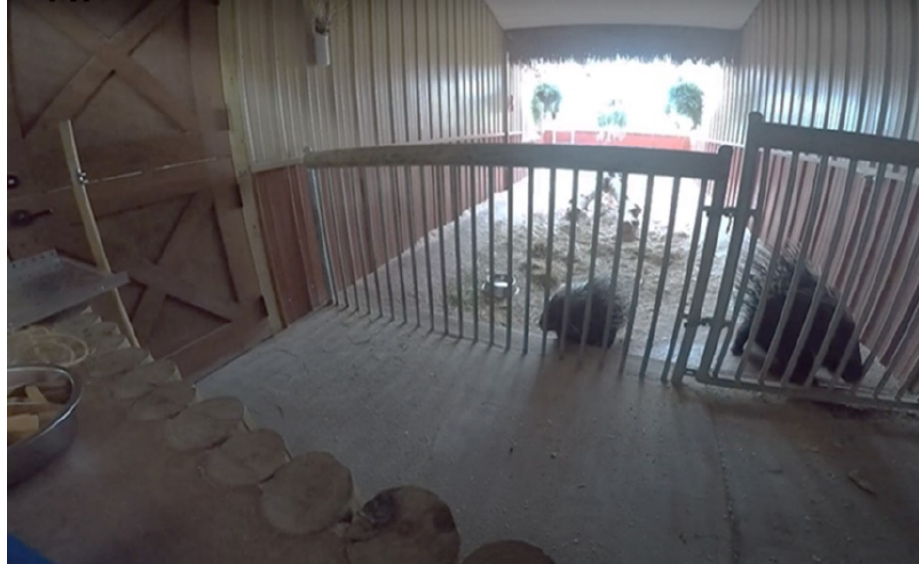
Figure 1. Porcupine indoor habitat including testing area.